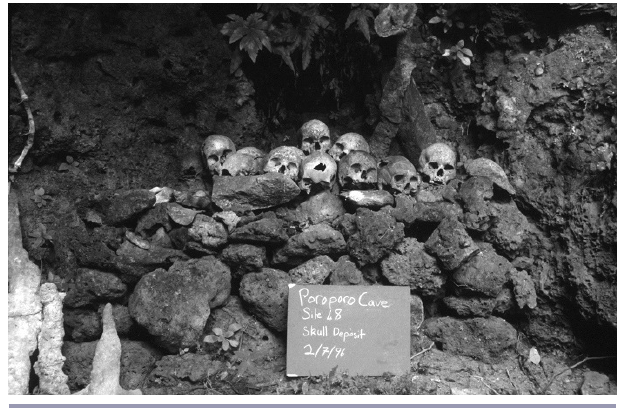
Fig. 2 . A small ancestral skull shrine located in Roviana Lagoon, New Georgia, Western province. Photographed by